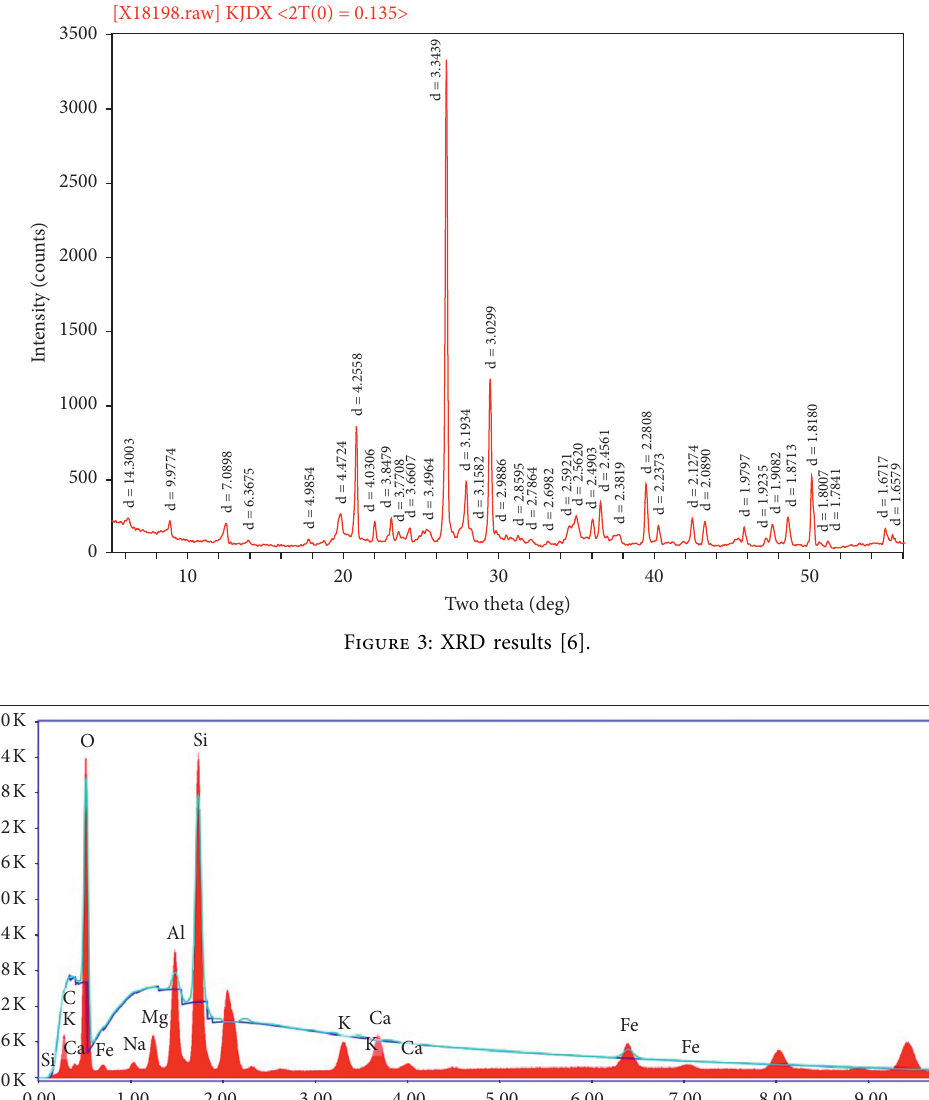
Figure 4: EDX spectrum of paleosol